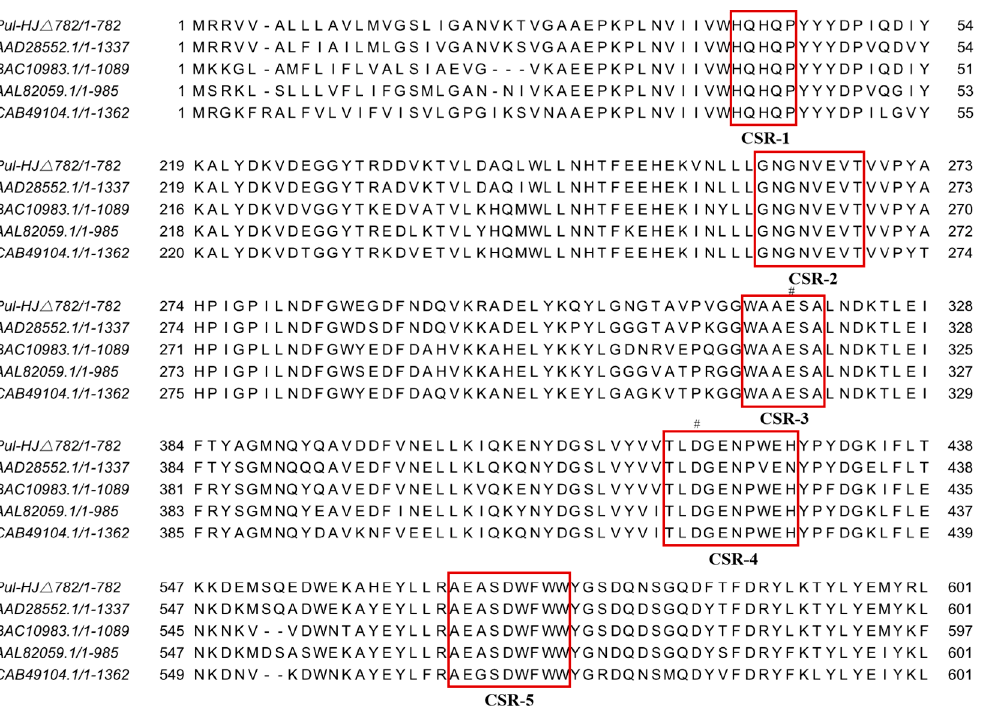
Figure 7. Conserved sequence regions (CSR) in the family GH-57. # indicates the catalytically active site.